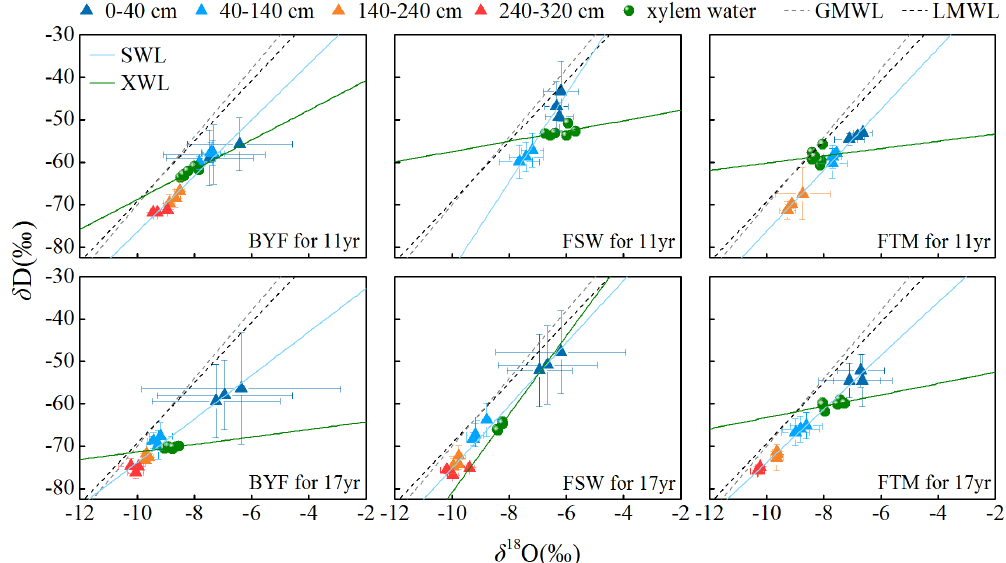
Figure 7. δ D and δ 18 O values in xylem water and different soil layers (0–40, 40–140, 140–240, and 240–320cm) for 11- and 17-year-old apple trees ( ± SD). GMWL and LMWL represent global and local meteoric water lines, respectively. LMWL: δ D = 7 . 1 δ 18 O + 2 . 1. SWL and XWL represent the soil and xylem water lines, respectively.